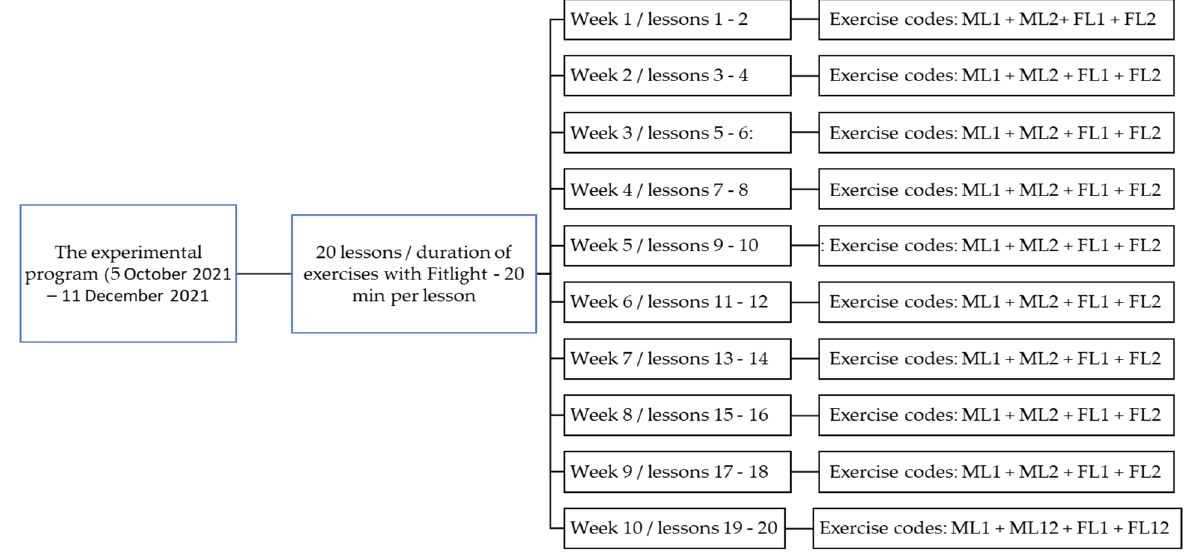
Figure 1. Scheduling of exercises per lesson during the experimental program. Examples of exercises: ML2: standing 1 m away from a gymnastics bench where 2 spots are placed at a distance of 2 m between them, moving to the gymnastics bench and touching the blue spot with the right hand or the white spot with the left hand and returning to the line of departure; the number of successes for each hand per 30 s is